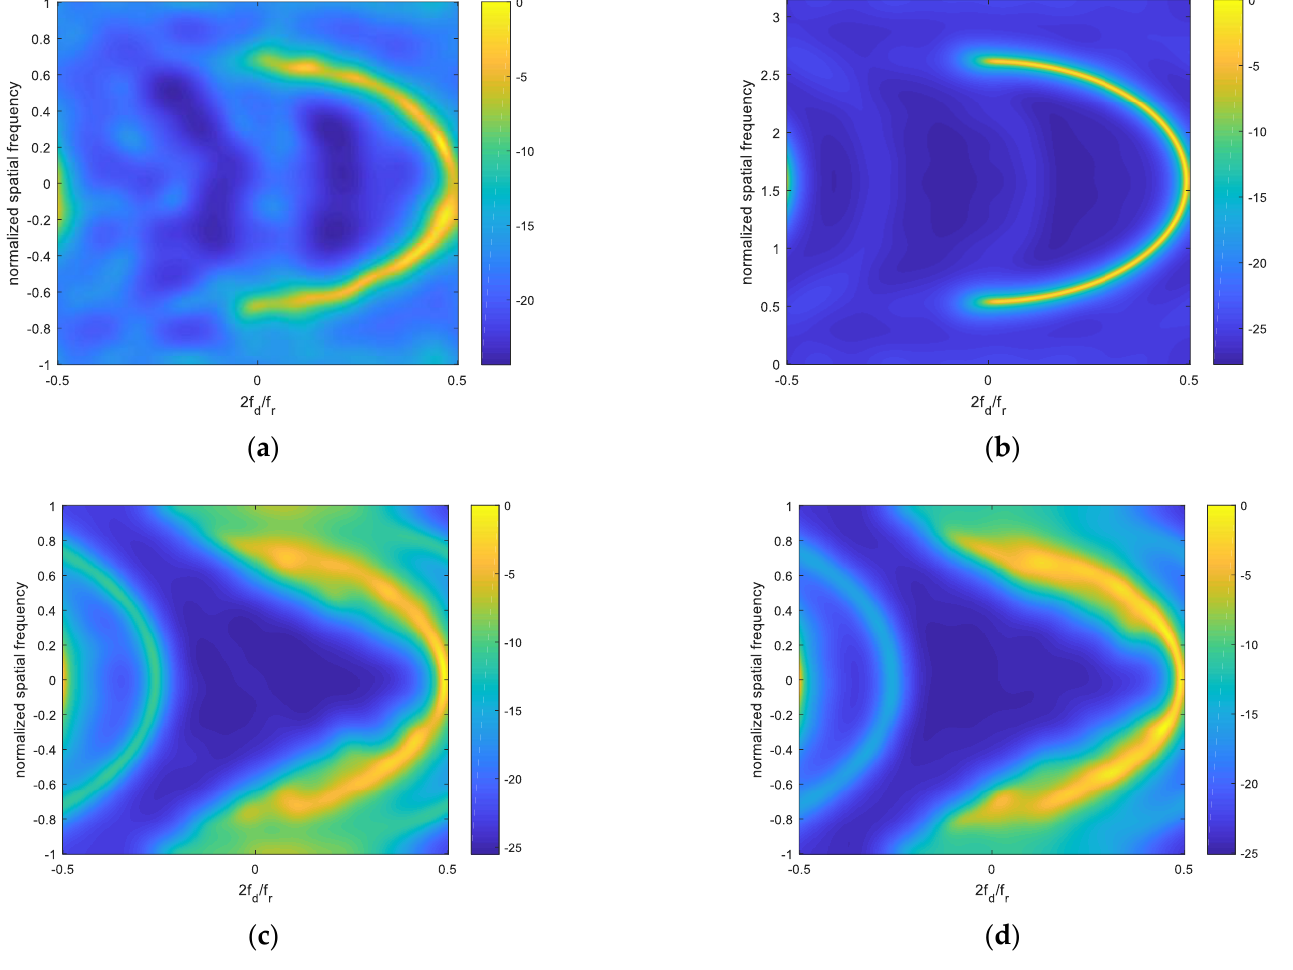
Figure 14. Ambiguous clutter power spectrum. ( a ) Proposed method; ( b ) ideal power spectrum; ( c ) MIMO; ( d ) FDA.